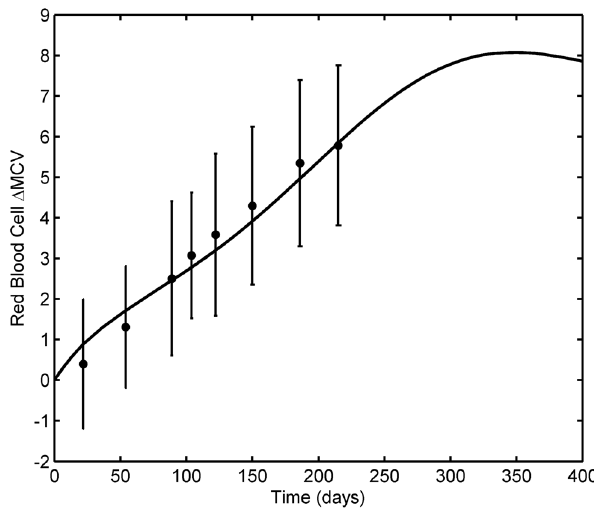
Figure 6. MCV model fit to average patient MCV data. Solid dots represent the data from literature and the solid line shows the model (Eqn. 7) fit with 6-TGN concentration of 158 pmol/8 6 10 8 RBCs. The model fits the data well; it reaches the steady state and stays at D MCV of , 8 fL, which is typically observed during 6-MP treatment at Riley Hospital for Children. Error bars represent standard error.